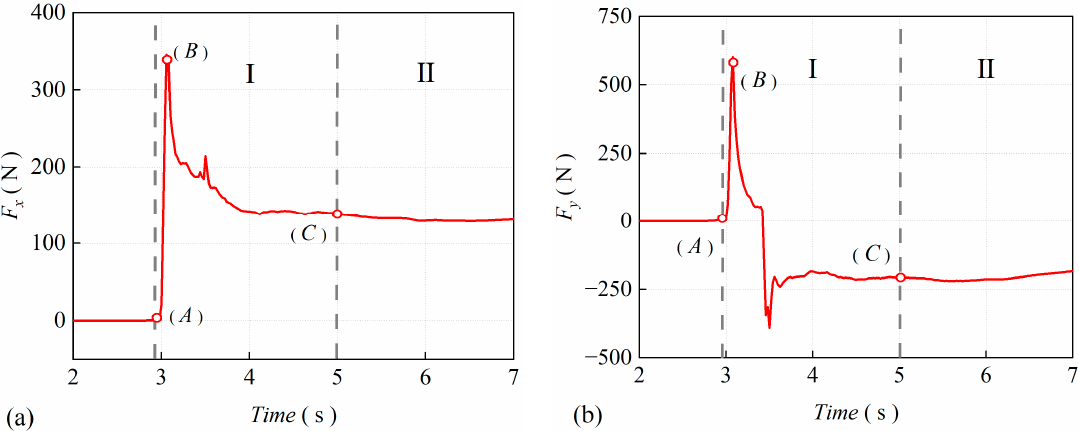
Figure 11. Time history of the ( a ) total horizontal forces and ( b ) total vertical forces on the box girder.